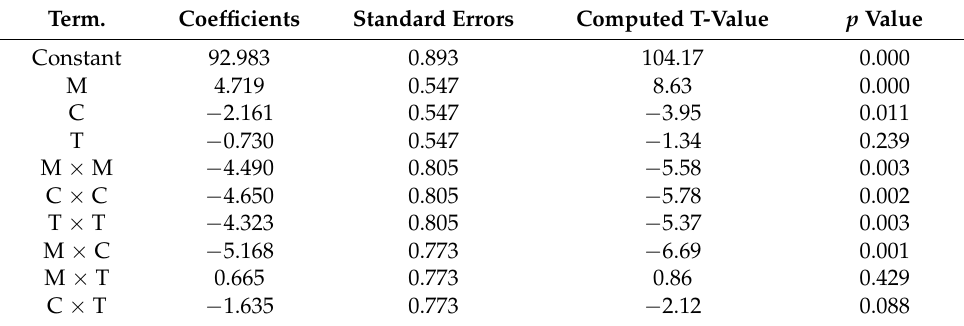
Table 8. Regression coefficient of the predicted quadratic polynomial model.